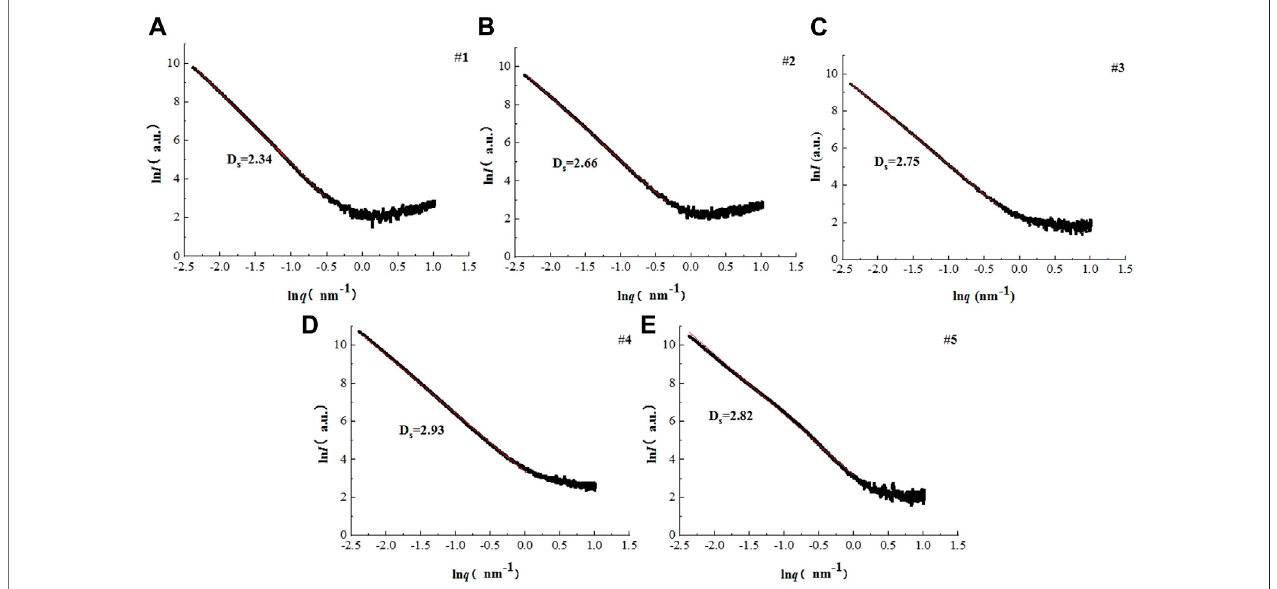
FIGURE 2 | Fractal curves. (A) Sample #1, (B) Sample #2, (C) Sample #3, (D) Sample #4, and (E) Sample #5.